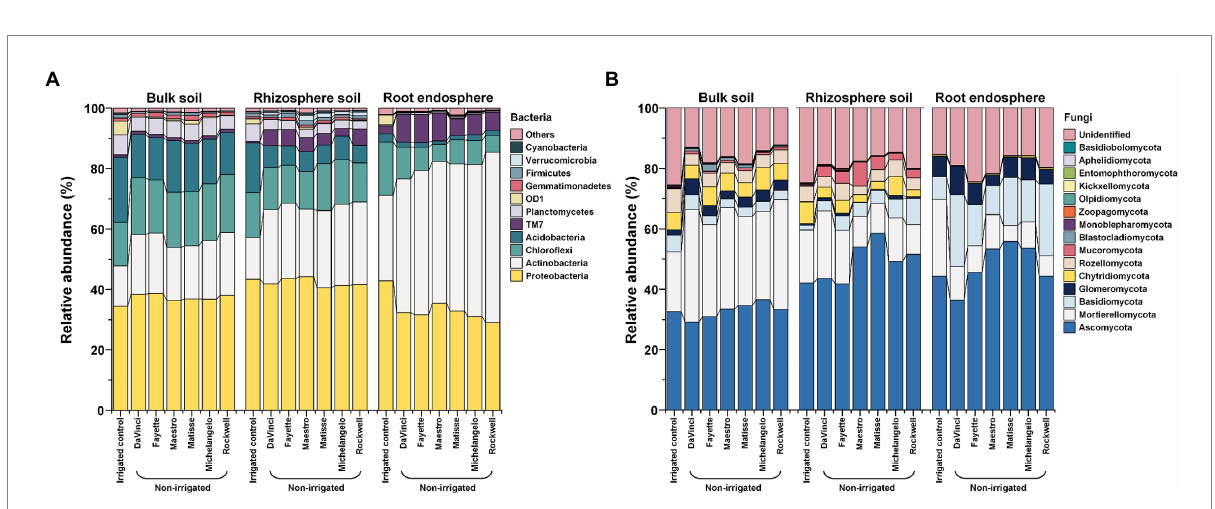
FIGURE 3 Relative abundance of the bacteria (A) and fungi (B) at the phylum level as affected by microhabitats, irrigations, and